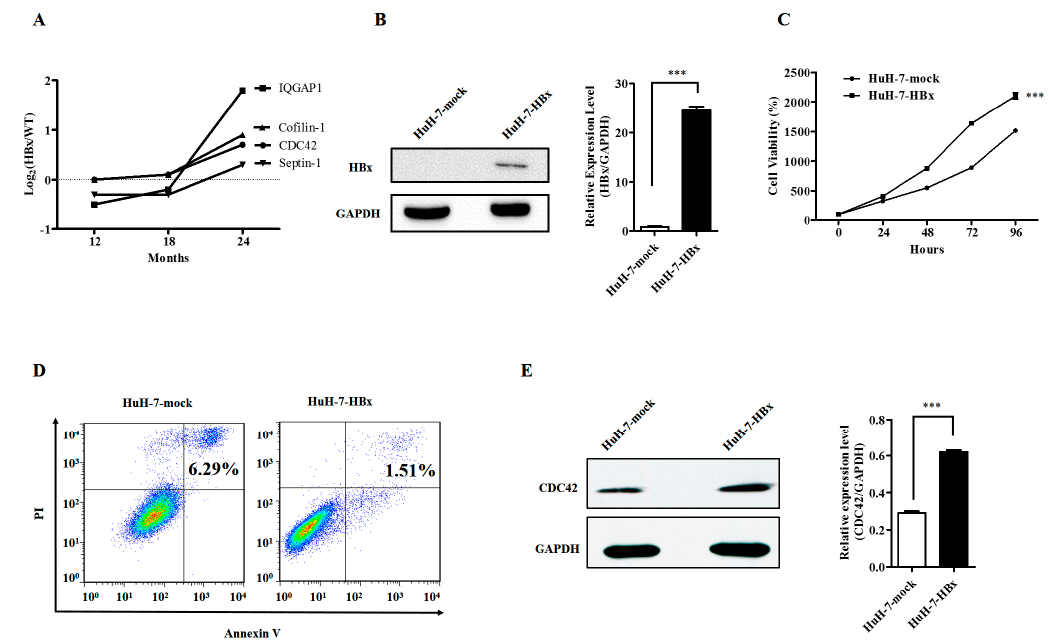
Figure 1. Hepatitis B virus X (HBx) protein promoted proliferation and inhibited apoptosis of HuH-7 cells with up-regulated expression of CDC42. ( A ) Up-regulated proteins associated with CDC42 as well as CDC42 in the 24-month-old HBx-transgenetic mice; ( B ) Western blot and real-time RT-PCR assays showed increased expression of HBx in HuH-7-HBx cells. *** p < 0.001. Data represent the mean ± SEM of three different experiments; ( C , D ) cell viability assay ( C ) and cell apoptosis assay ( D ) was performed in HuH-7-mock cells and HuH-7-HBx cells. *** p < 0.001. Data represent the mean ± SEM of three different experiments; ( E ) Western blot and real-time RT-PCR assays showed increased expression of CDC42 in HuH-7-HBx cells. *** p < 0.001. Data represent the mean ± SEM of three different experiments.